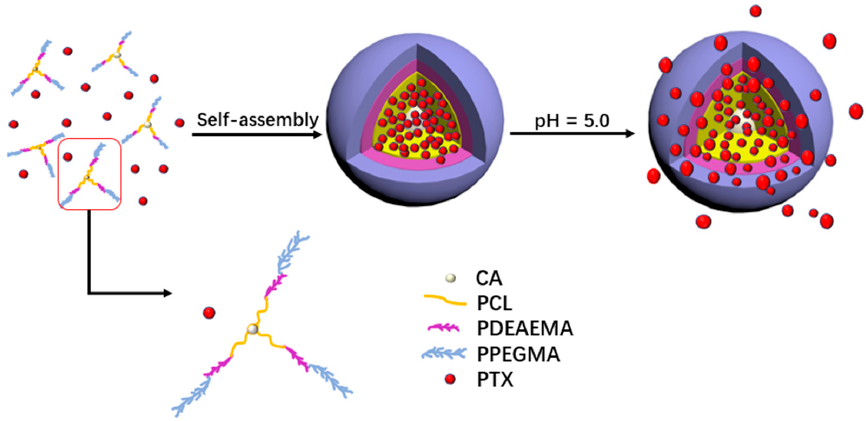
Figure 1. Schematic diagram of self-assembly and pH response release of polymer drug-loaded micelles.